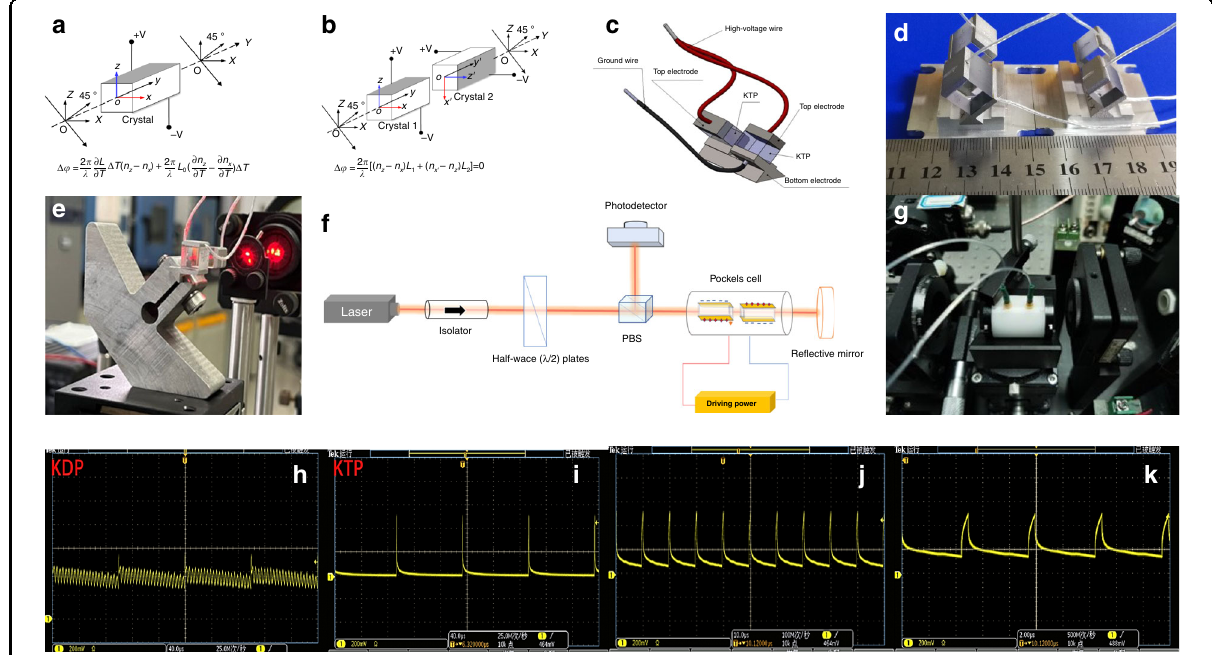
Fig. 11 The structure and the piezoelectric ringing of EO Q-switch based on H-RKTP. Schematic of the principal diagram of a temperature- controlled single-crystal and d temperature-compensated double-crystal EO switches; b Photograph and c designs of KTP EO Q-switch; e Online monitoring device for EO switch pair installation; f Experimental setup for characterization of piezoelectric ringing effects (PE); g Pockels cell (PC) to be tested; Waveform diagram of the h KDP PC under 10 kHz, and KTP PC under i 10 kHz, j 100 kHz, k 200